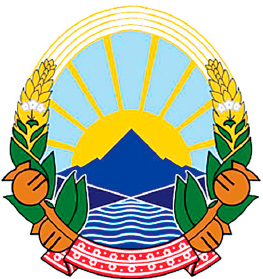
Figure 9. Coat of Arms of the Republic of Macedonia, 2009.